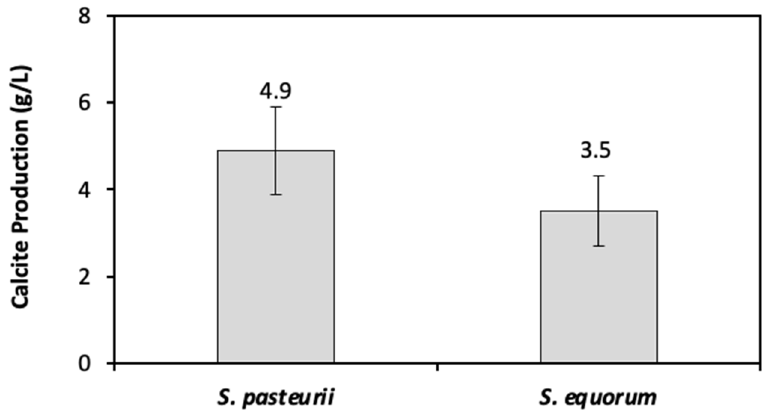
Figure 4. Calcite production by the end of precipitation assays for S. pasteurii and S. equorum . Bars indicate standard deviation.